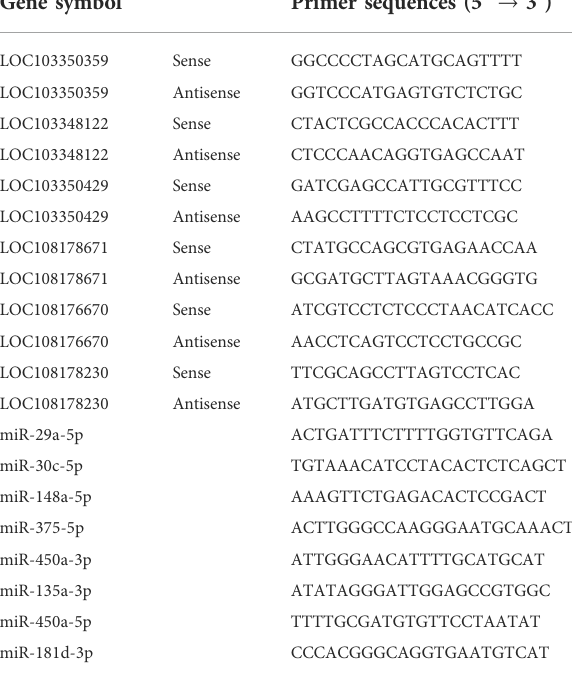
TABLE 1 Primer information for each